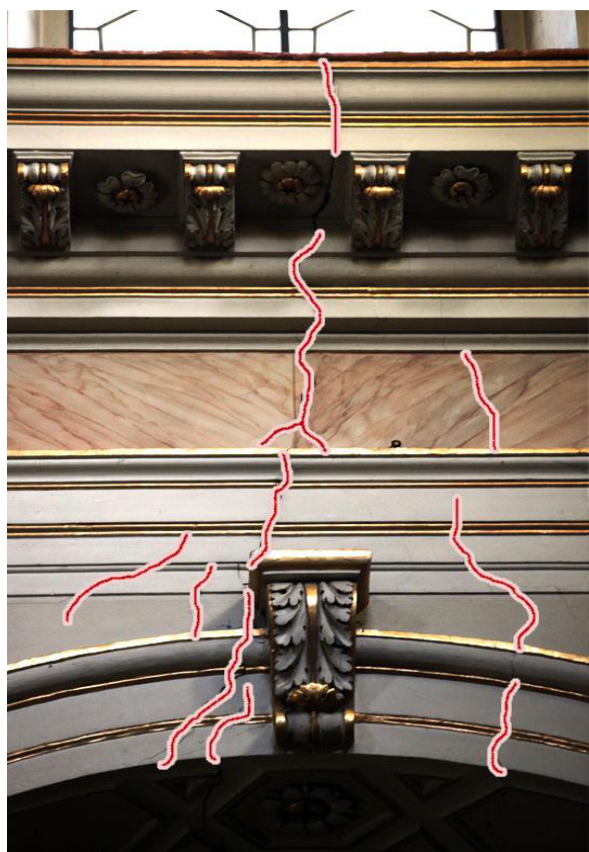
Figure 11. Crack of an arch to the overturning of the façade